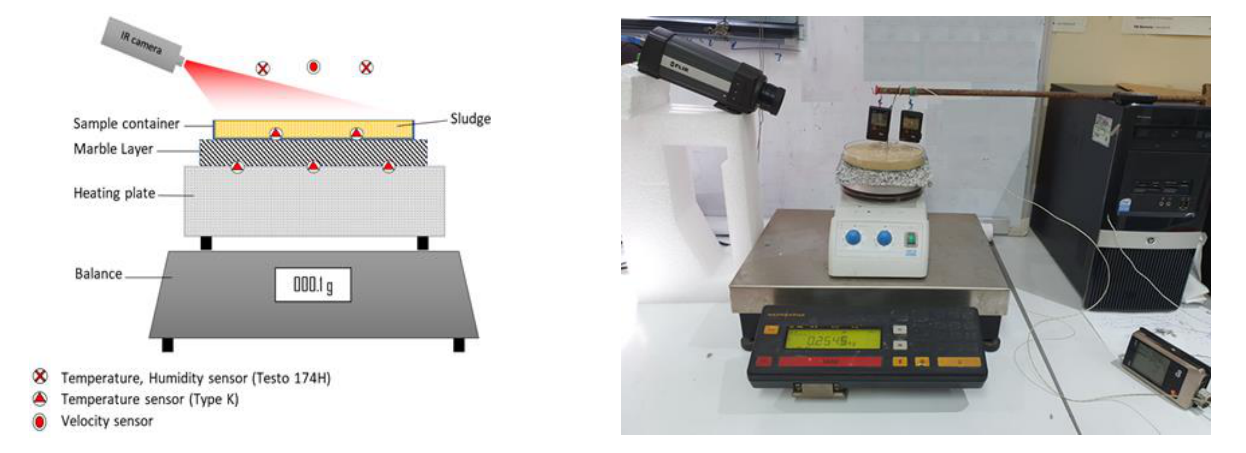
Figure 1. Scheme of the experimental set-up.